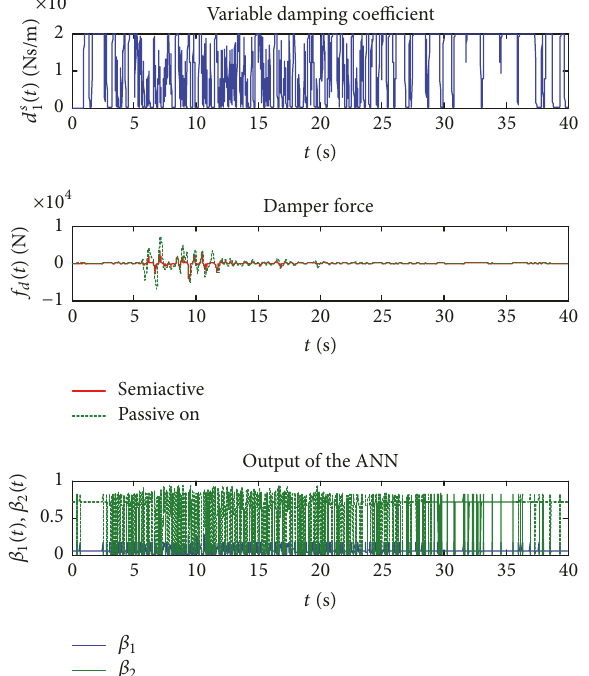
Figure 18: Simulation results for the Kobe NS (1995) earthquake disturbance; variable damping coefficient 𝑑 𝑠 1 (𝑡) , force of damper 𝑓 𝑑 (𝑡) , and output signals of the ANN 𝛽 1 (𝑡) and 𝛽 2 (𝑡) .